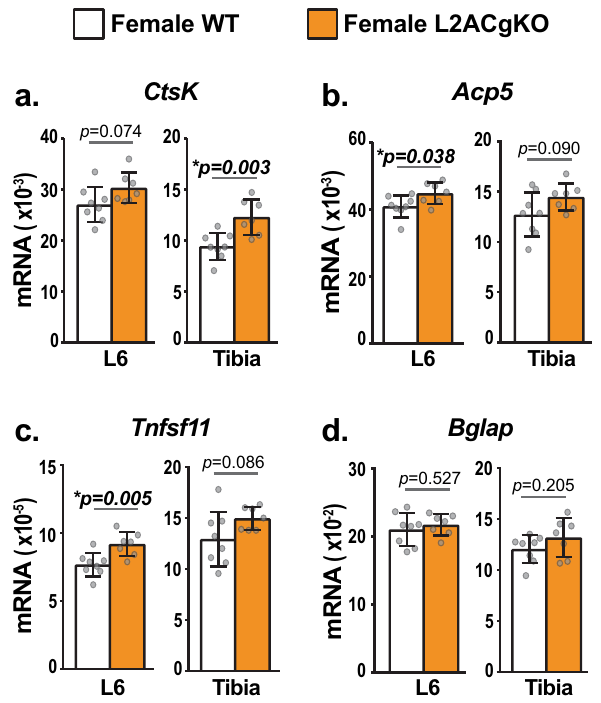
Figure 3. Gene expression analysis of bone formation and resorption marker genes in L2ACgKO bones. qRT- PCR was used to measure mRNA levels of target genes in lumbar vertebrae 6 (L6), and tibias of 5-week-old female Lamp2AC global knock-out (L2ACgKO) mice and their age-matched controls (wild-type mice, WT). ( a–d ) mRNA levels of osteoclast marker genes C athepsin K (CtsK) and Trap (Acp5) ( a,b ) ; Tnfsf11 encoding pro- resorptive cytokine RANKL ( c ), and osteoblast marker gene Bglap encoding Osteocalcin ( d ) were measured. Levels of target genes were normalized to the housekeeping gene β-actin. n = 7–8 mice/group. Bars indicate mean ± STDEV. p values were calculated and evaluated by Welch’s t -test.; *, p <